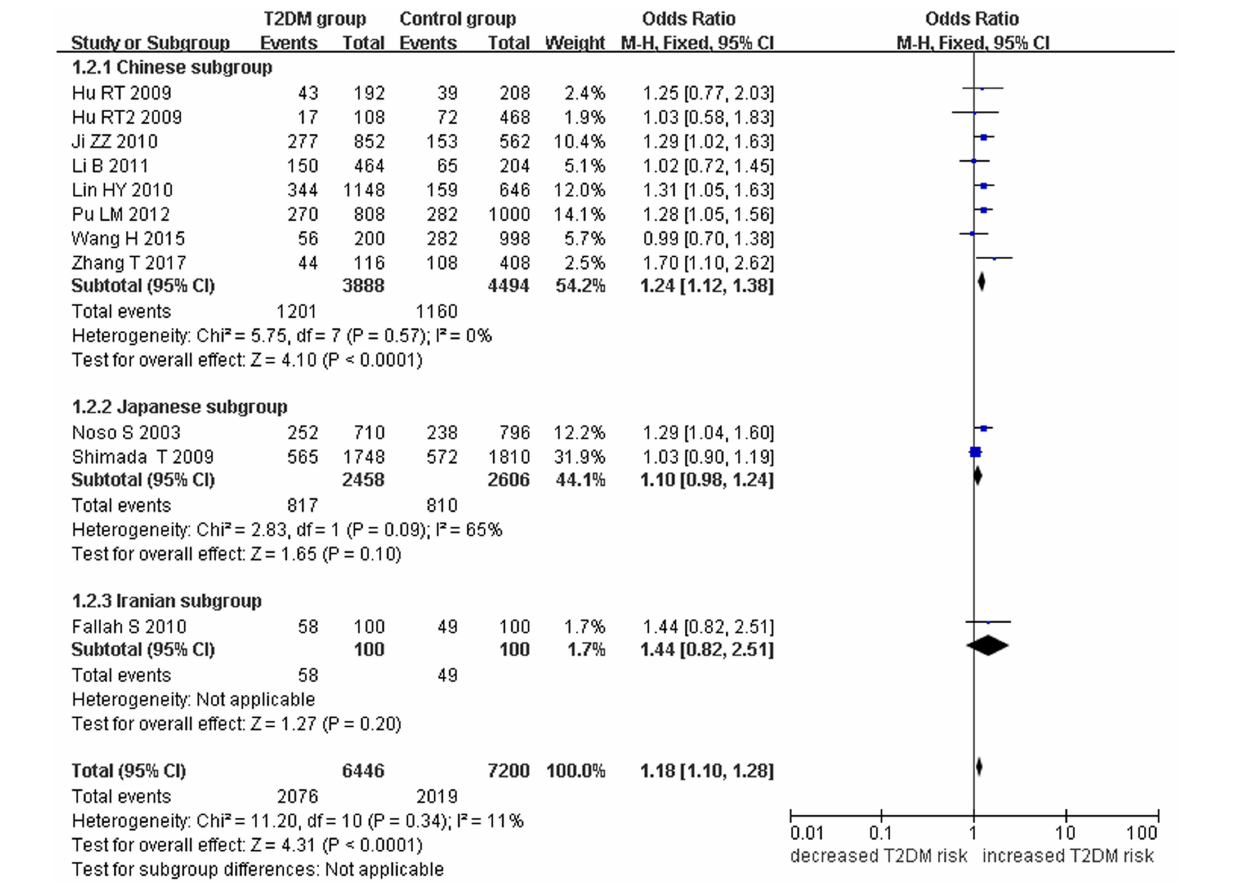
FigUre 1 | Forest plot of type 2 diabetes mellitus (T2DM) associated with small ubiquitin-like modifier 4 ( SUMO4 ) gene M55V polymorphism under an allelic genetic model (distribution of V allelic frequency of SUMO4 gene).